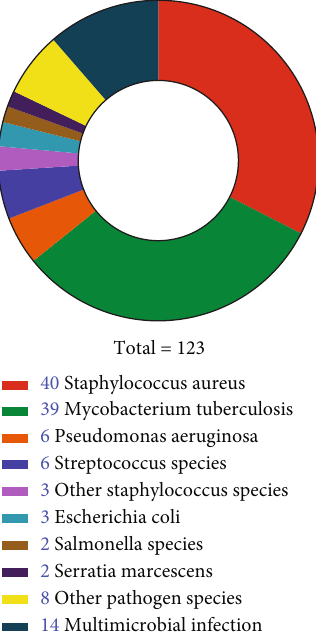
Figure 3: Distributions of pathogen culture outcomes of the BO patients